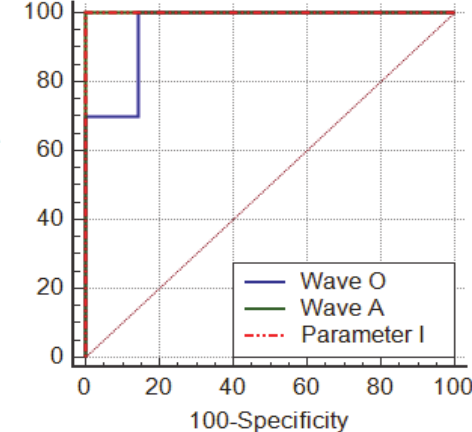
Fig.5: ROC curves for O- wave amplitude (AUC=0.96, p<0.0001), A- wave amplitude (AUC=1, p<0.0001), and the diagnosis parameter “I” (AUC=1, p<0.0001).